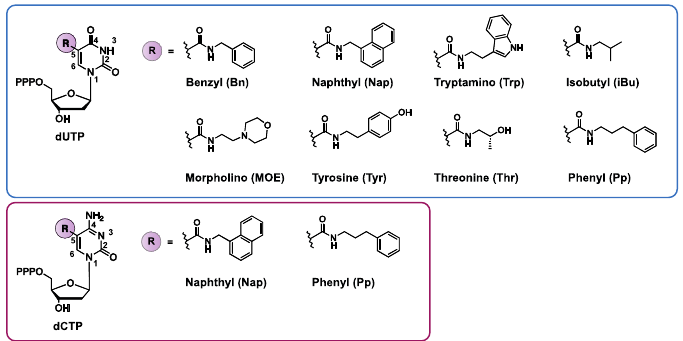
Figure 7. Overview of nucleobase modifications introduced at the C5 position of dUTP (deoxyuridines triphosphate) or dCTP (deoxycytidine triphosphate) for the synthesis of so-called SOMAmers. PPP—triphosphate. 5-benzylaminocarbonyl (Bn), 5-naphthylmethylaminocarbonyl (Nap), 5-tryptaminocarbonyl (Trp), 5-isobutylaminocarbonyl (iBu), 5-morpholinoethylamino- carbonyl (MOE), 5-hydroxyphenylethylaminocarboxyl (Tyr), 5-hydroxypropylaminocarbonyl (Thr), 5-phenylpropylaminocarbonyl (Pp).